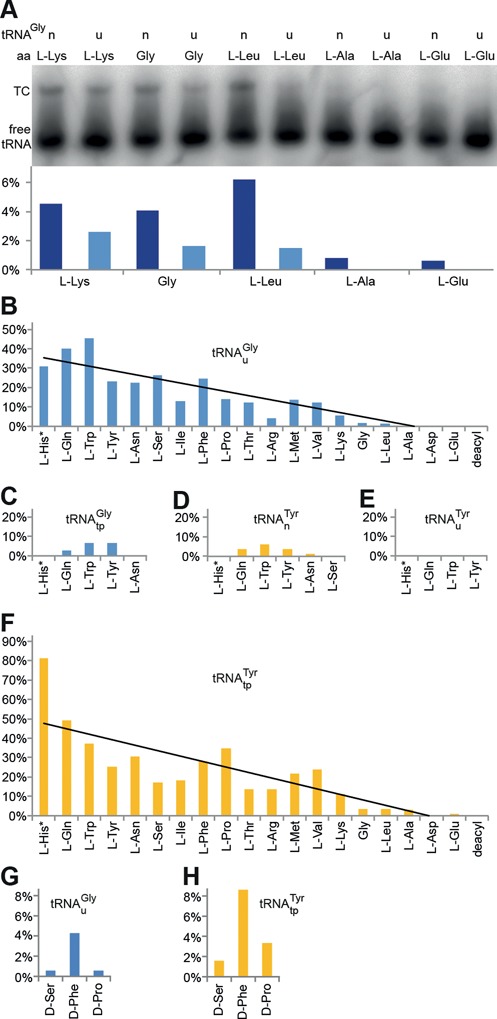
TC formation with wild-type EF-Tu•GTP and aa-tRNA. The esterified amino acids are ordered in a descending order of binding energy contribution according to (47) (* data for l-His were unavailable, we arbitrarily put it to the left). (A) Upper panel: EMSA with native (n) and unmodified (u) tRNAGly acylated with weakly contributing l-aa. Lower panel: relative quantification of TCs versus unbound tRNA. (B–F) Evaluation of EMSAs with several tRNAs acylated with canonical aa. (B) unmodified tRNAGlyu, (C) transplanted tRNAGlytp, (D) native tRNATyrn, (E) unmodified tRNATyru, (F) transplanted tRNATyrtp. (G, H) Evaluation of EMSAs with tRNAGlyu (G) and tRNATyrtp (H) misacylated with d-aa (see also Supplementary Figure S1).